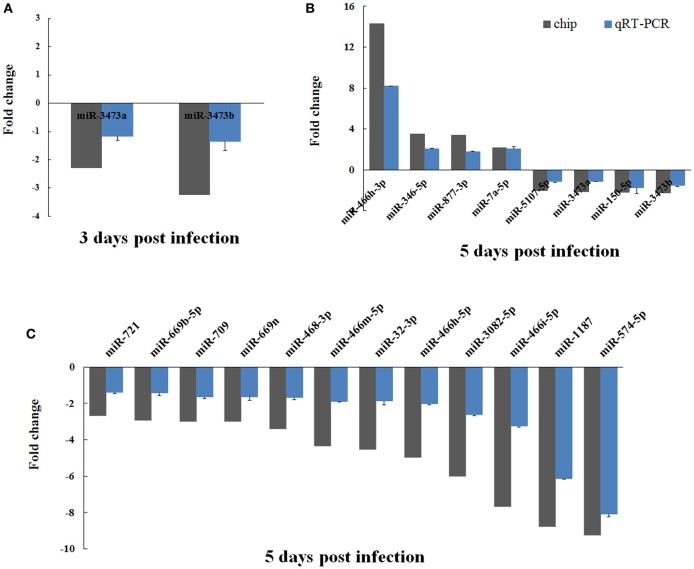
Verification of microarray data using real-time PCR. The expression of the 20 differentially expressed miRNAs identified by microarray analysis were analyzed using real-time PCR. The two miRNAs changed by 3 days post-infection are shown in (A). The 20 miRNAs changed at 5 days post-infection are shown in (B) and (C). The detection for each miRNA was repeated three times and the standard deviation was denoted as error bar.